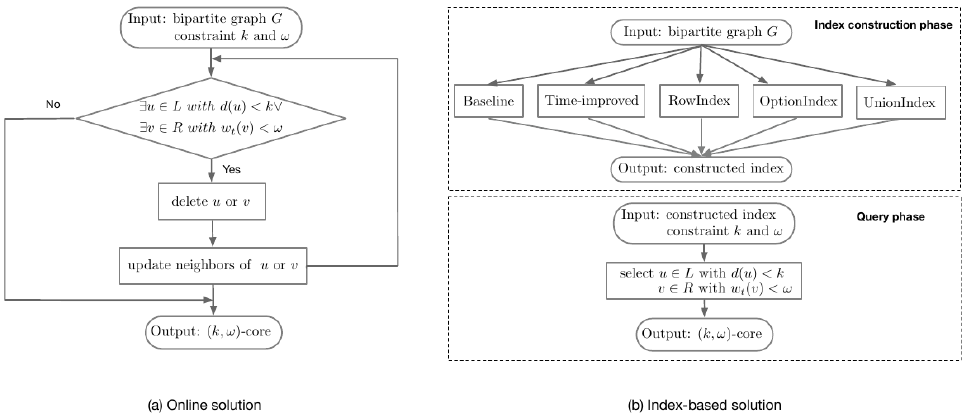
Figure 2. General framework of the online and index-based solutions.